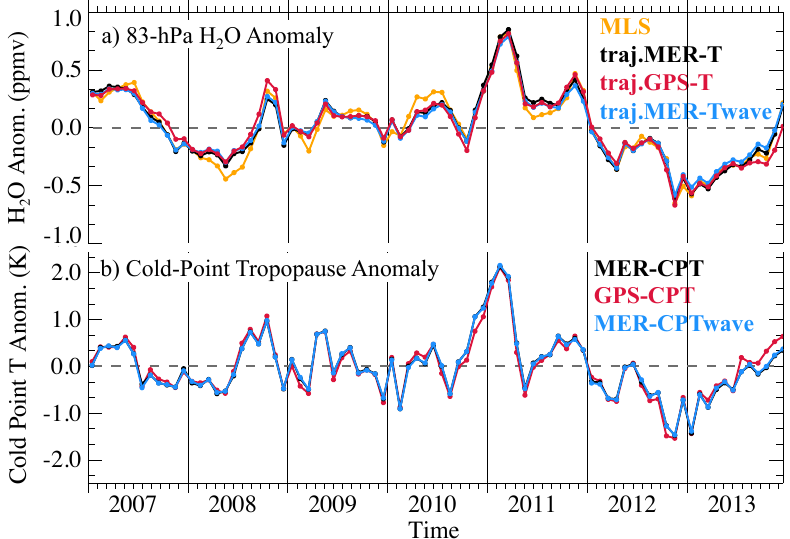
Figure 8. (a) Trajectory simulated H 2 O anomalies compared with the MLS observations; and (b) cold-point temperature anomalies from three temperature data sets. All time series are averaged over the deep tropics (18 ◦ N–18 ◦ S). All trajectory results in panel a are weighted by the MLS averaging kernels for fair